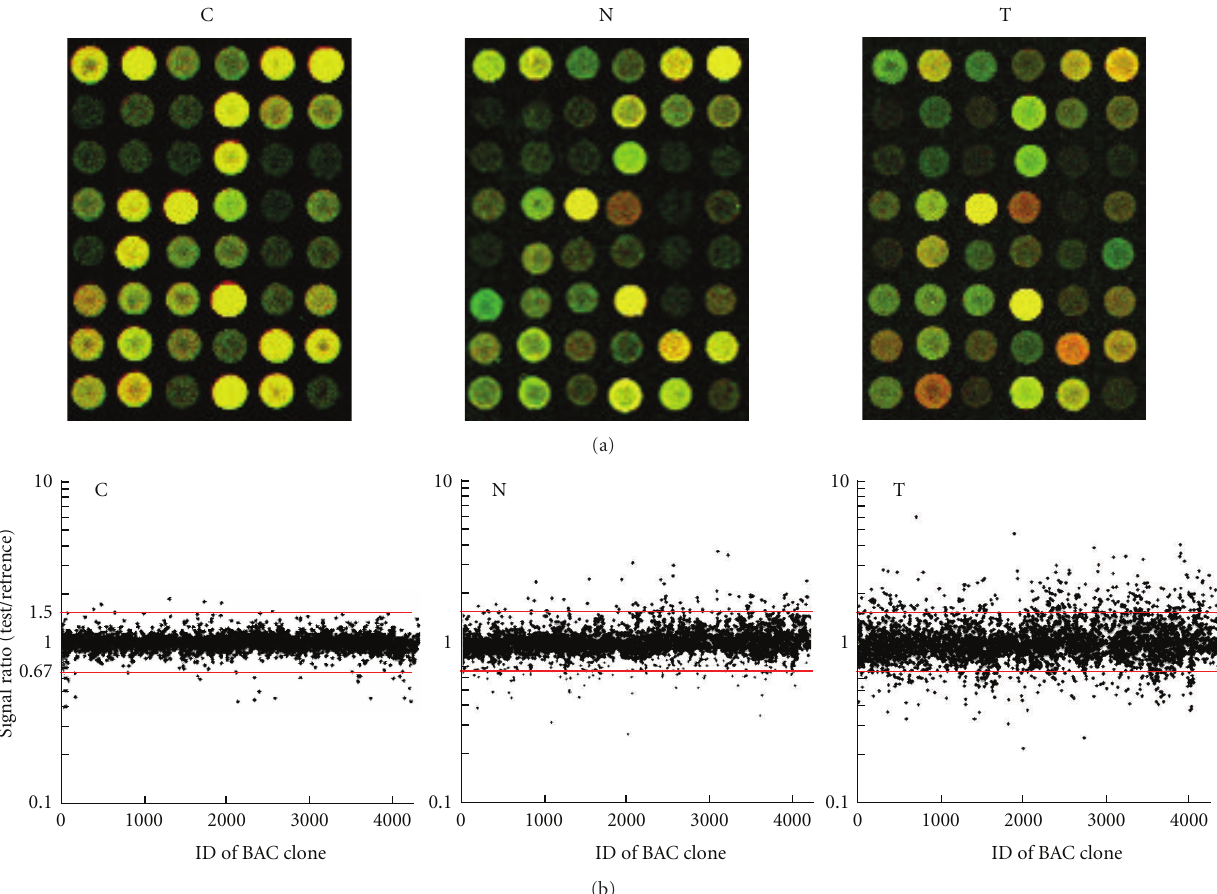
Figure 1: Genome-wide DNA methylation analysis by BAMCA. (a) Representative examples of scanned array images in a sample of normal pancreatic tissue obtained from a patient without ductal adenocarcinoma of the pancreas (C) and samples of both noncancerous pancreatic tissue (N) and cancerous tissue (T) obtained from a single patient with ductal adenocarcinoma of the pancreas. Test and reference DNA labeled with Cy3 and Cy5 was cohybridized, respectively. (b) Representative examples of scattergrams of the signal ratios (test signal/ reference signal) in each C-, N-, and T-sample. In all C-samples, the signal ratios of 97% of the BAC clones were between 0.67 and 1.5 (red lines). Therefore, in N- and T samples, DNA methylation status corresponding to a signal ratio of less than 0.67 and more than 1.5 was defined as DNA hypo- and hypermethylation on each BAC clone relative to C-samples, respectively. In N-samples, many BAC clones showed DNA hypo- or hypermethylation. In T-samples, more BAC clones showed DNA hypo- or hypermethylation, and the degree of DNA hypo- or hypermethylation, that is, deviation of the signal ratio from 0.67 or 1.5, was increased in comparison with